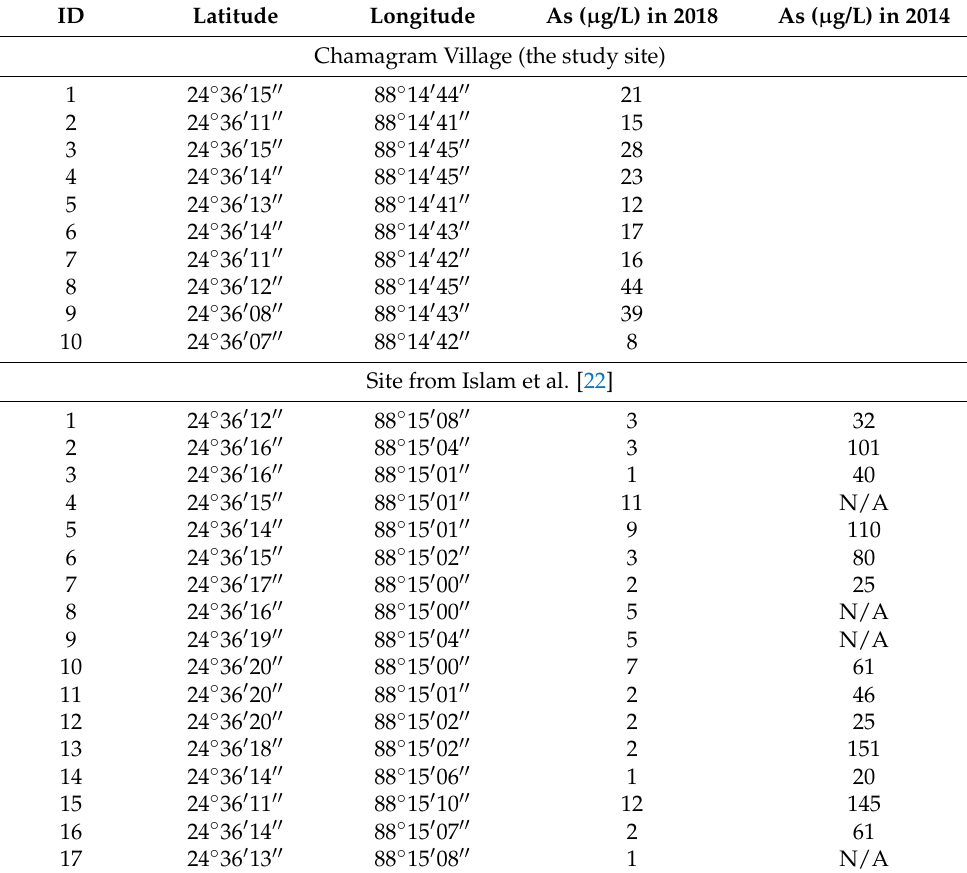
Table 2. As test results for the study site from the present and previous